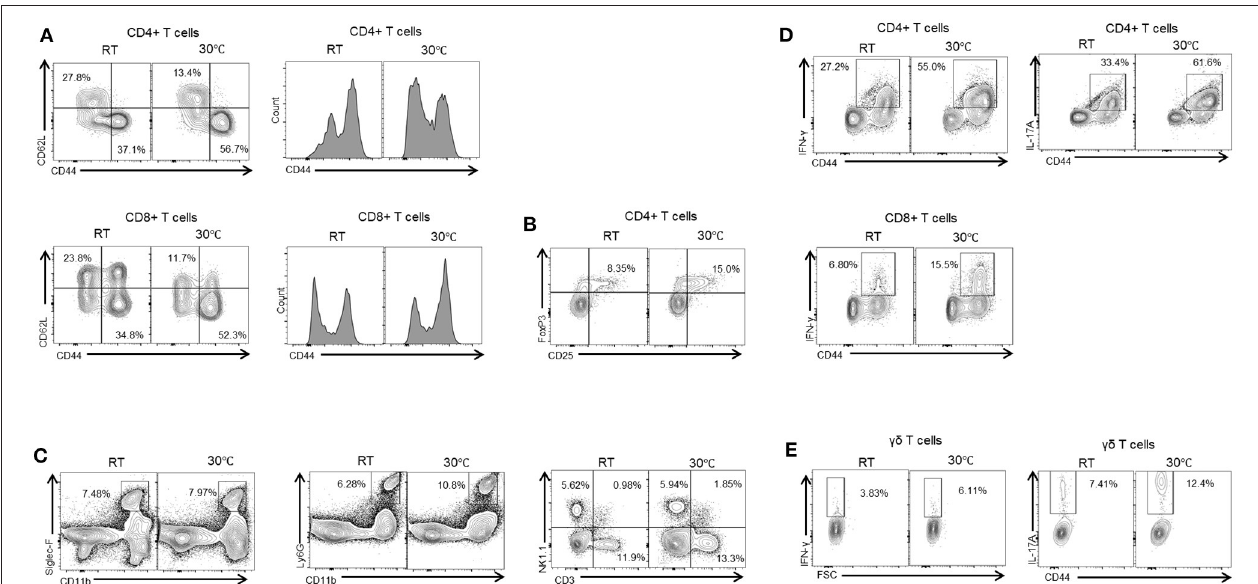
FIGURE 3 | Thermoneutral housing enhances immune cells infiltration of the liver. Isolated liver MNCs were analyzed for CD4 + T cells, CD8 + T cells (A) , regulatory T cells (B) , monocytes, neutrophils, and NK cells (C) by flow cytometry. Liver MNCs were evaluated through intracellular staining for IFN- γ -producing and IL-17A-producing CD4 + T cells, CD8 + T cells (D) , and γδ T cells (E)